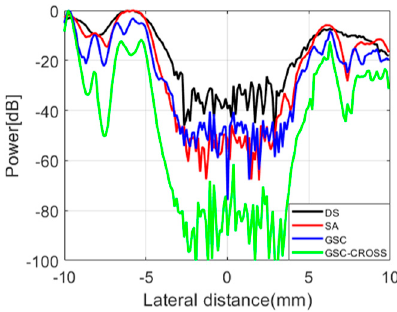
Figure 5. Contrast of beamforming responses for different beamforming algorithms. ( a ) DS; ( b ) SA; ( c ) GSC (L = 32, Δ = 20); ( d ) GSC-CROSS (L = 32, Δ = 20). The dynamic range of image is 80 dB.